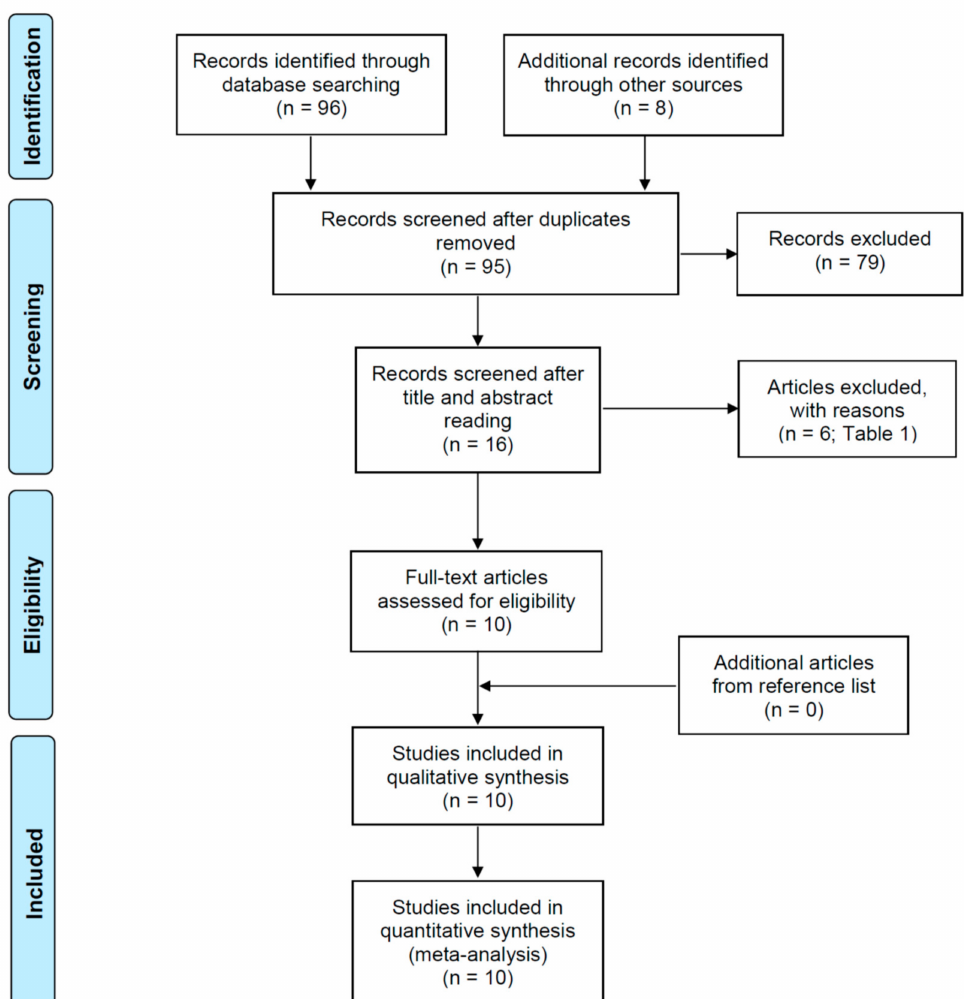
Figure 1. Flow diagram of the search strtegy of the systematic review and meta-analysis following the Preferred Reporting Items for Systematic Reviews and Metaanalyses (PRISMA)